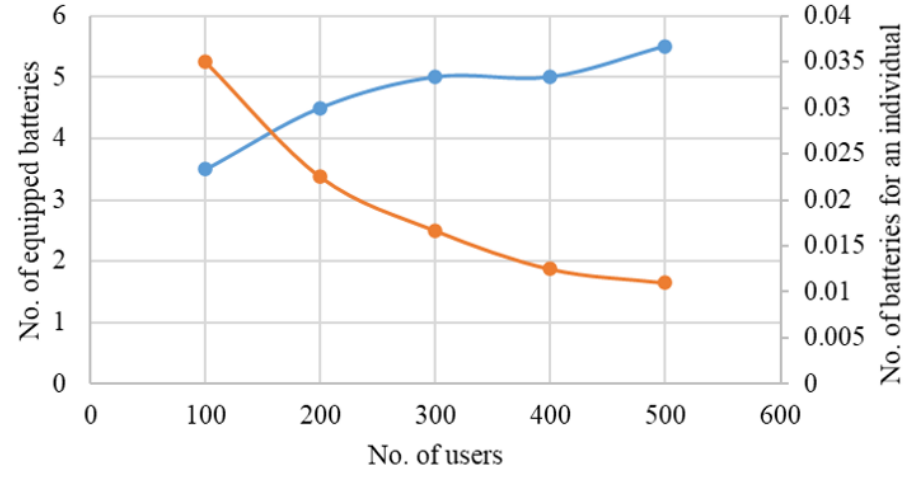
Figure 11. Analysis of scale